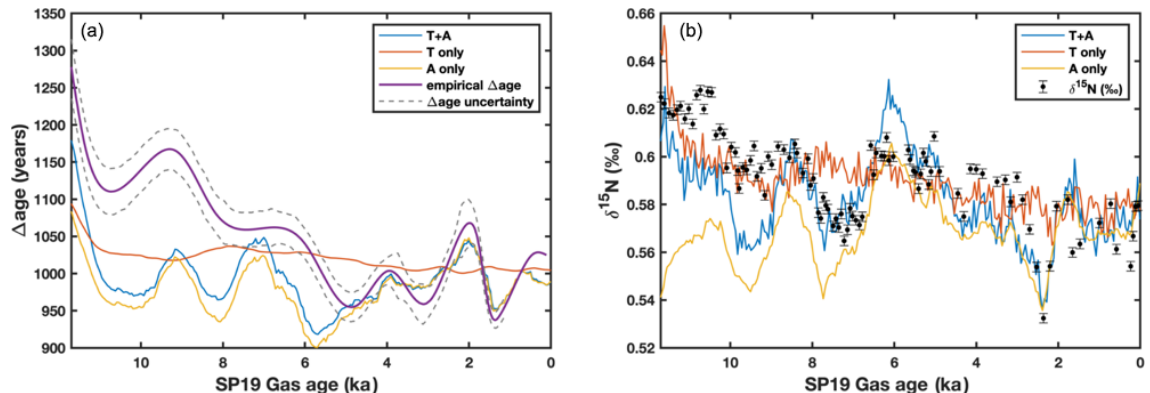
Figure 4. (a) Comparison of modeled (cid:49) age (red, yellow, and blue lines) and empirical (cid:49) age (purple line). Gray dashed lines represent (cid:49) age uncertainty. (b) Modeled and actual δ 15 N data (Winski et al.,